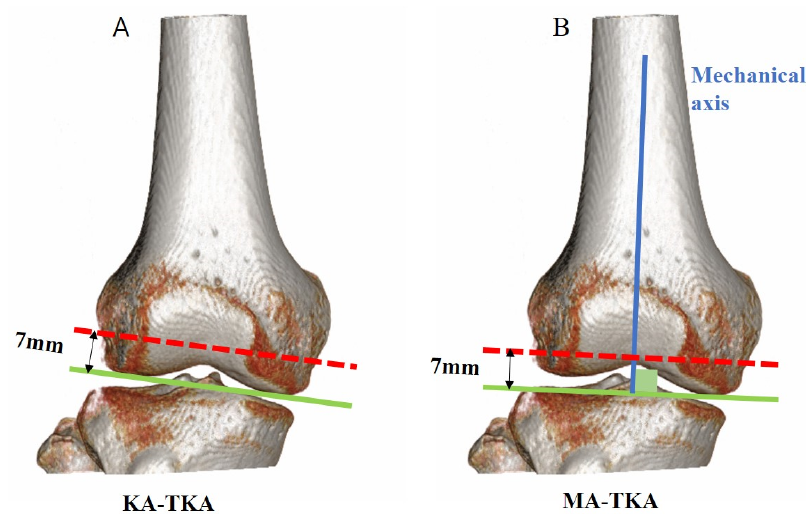
Figure 1. ( A ) Distal femoral cutting of kinematically aligned total knee arthroplasty (KA-TKA). ( B ) Distal femoral cutting of mechanically aligned total knee arthroplasty (MA-TKA). The cutting thickness was 7 mm.